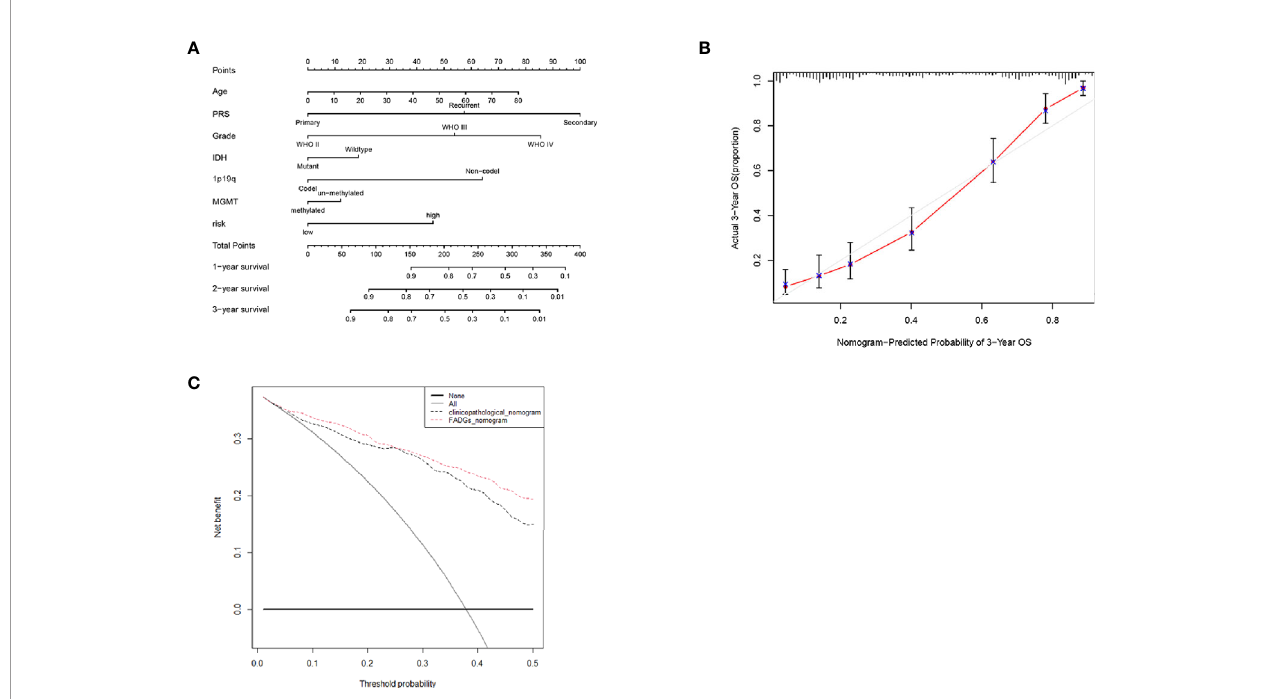
FIGURE 10 | Nomogram was constructed with the risk score and clinical characteristics (A) Nomogram of the clinical features and risk score. (B) Calibration curve of the actual 3-year OS. (C) DCA analysis of the FADGs